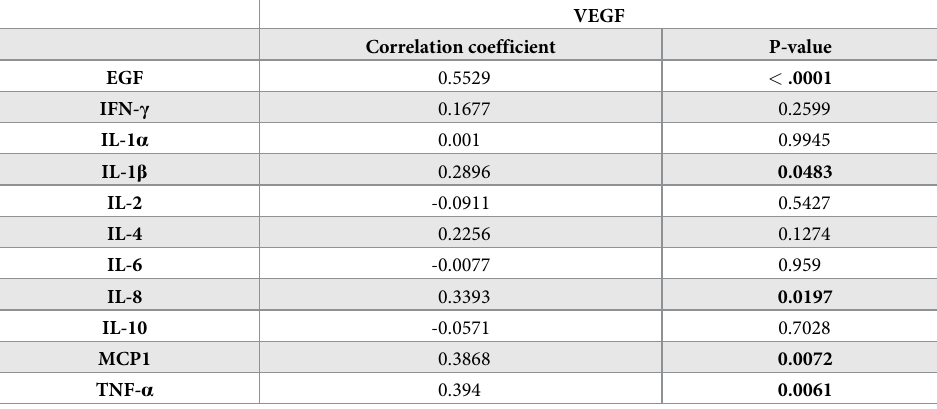
Table 2. Correlation analysis between VEGF protein levels and inflammation